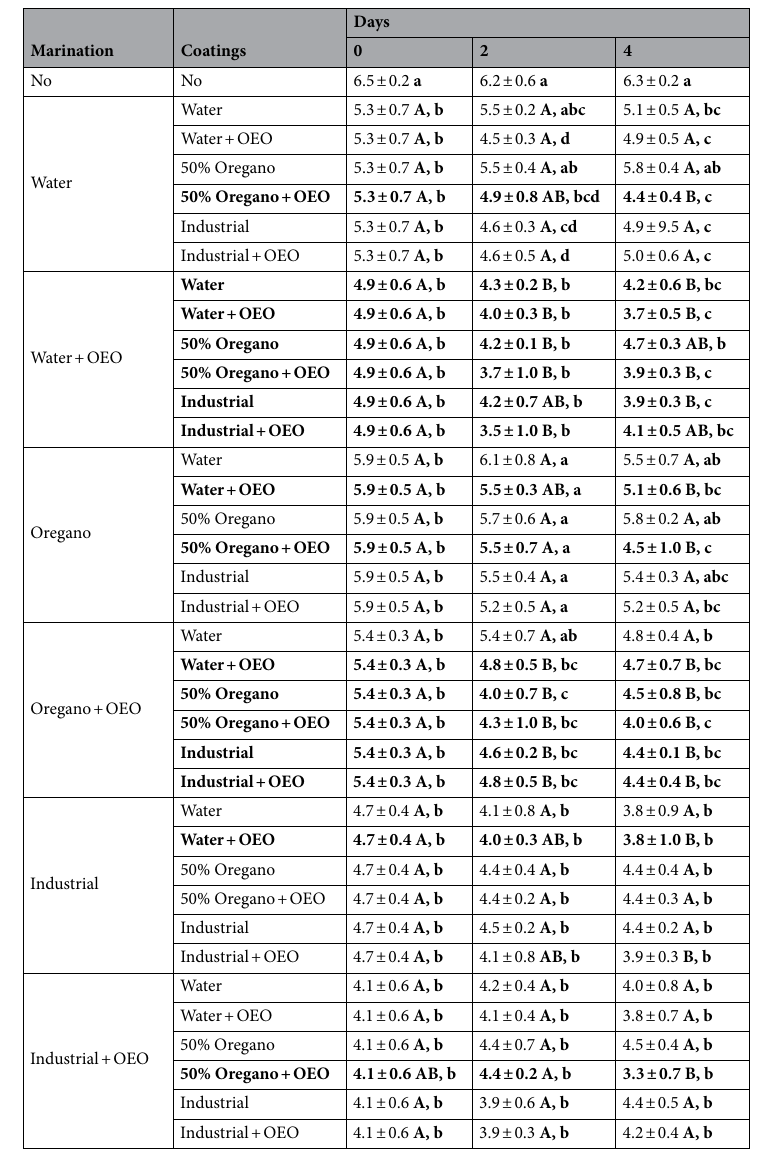
Table 4. Combined effect of marinades and edible coatings prepared of water, hydro-distilled oregano extract and industrial oregano hydrolate supplemented with or without 0.2% OEO in the inactivation of S. Typhimurium FS8 in pork meat at 4 °C. Antimicrobial combinations leading in reductions during storage are indicated in bold. Each value represents an average (± standard deviation) of six replicates. Different capital letters within the same row indicate statistical differences ( P < 0.05) of samples during storage at 4 °C according to Tukey’s HSD. Different lowercase letters within the same column indicate statistical differences ( P < 0.05) among samples marinated in the same solution and covered with different coatings according to Tukey’s